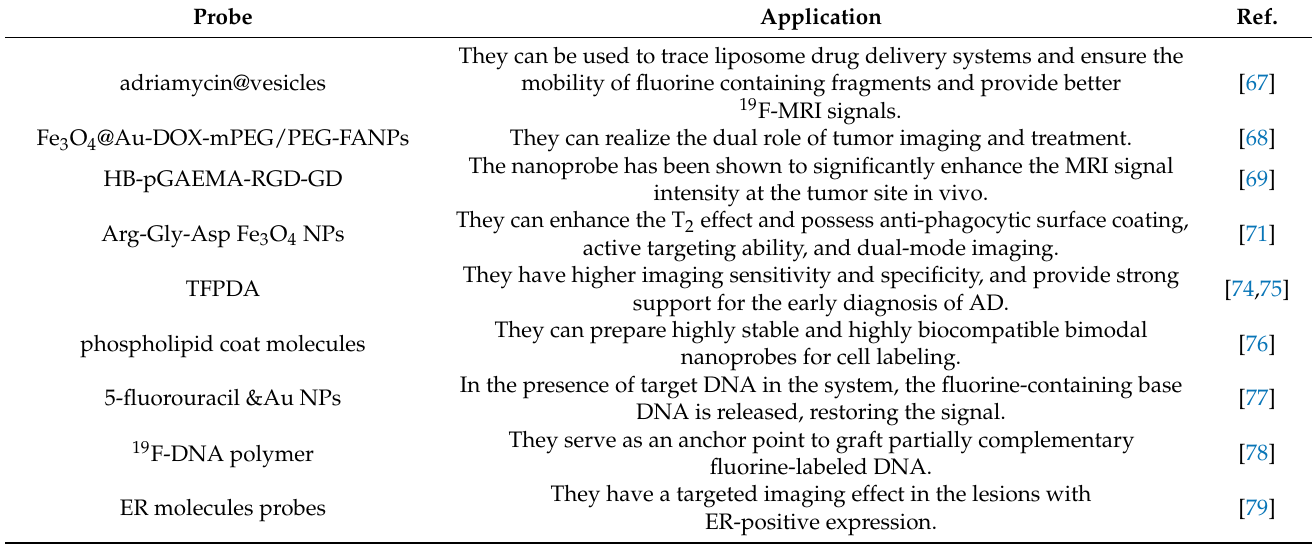
Table 2. Summary of the application of environment responsive MRI